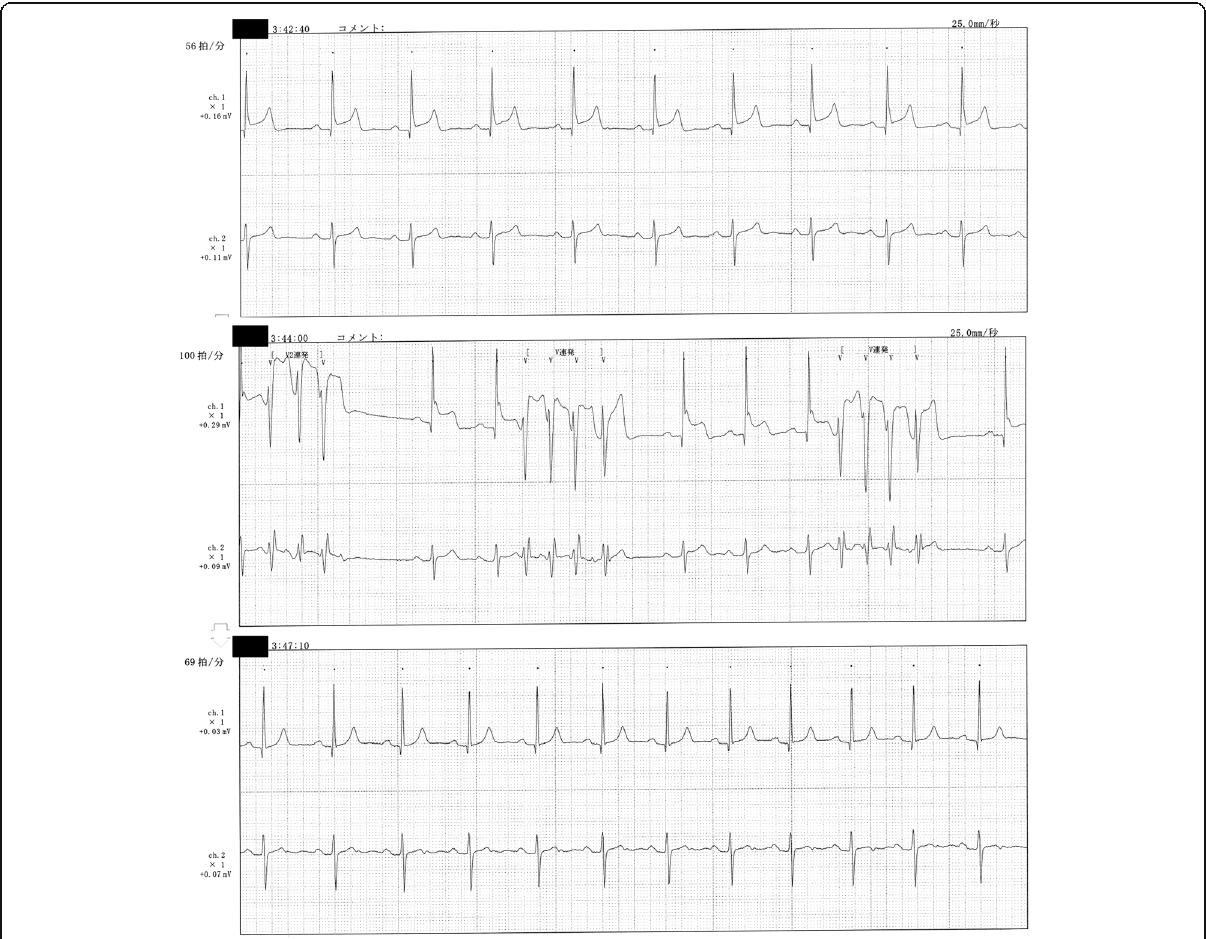
Fig. 2 Holter electrocardiogram (ECG). The patient ’ s ECG was continuously monitored on day 4 of treatment. Holter ECG revealed that ST segment elevations appeared together with angina (upper panel) and were followed by short-run tachycardia 1 min later (middle panel). The abnormal findings on ECG disappeared 4 min after sublingual nitroglycerin administration (lower